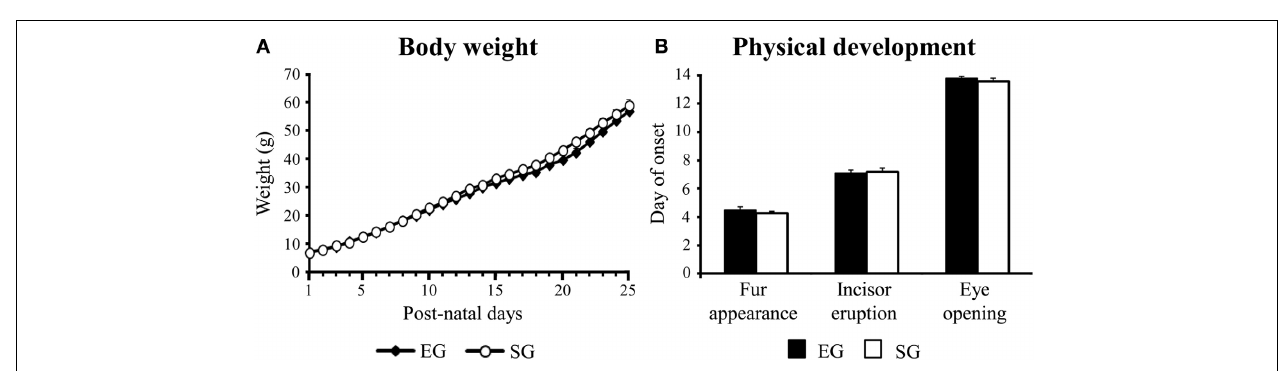
FIGURE 2 | Results of pre-reproductive maternal rearing condition on physical development. Body weight of pups from pnd 1 to pnd 25 (A) ; day of onset of fur appearance, incisor eruption, and eye opening (B) . Results are reported as mean ± s.e.m.